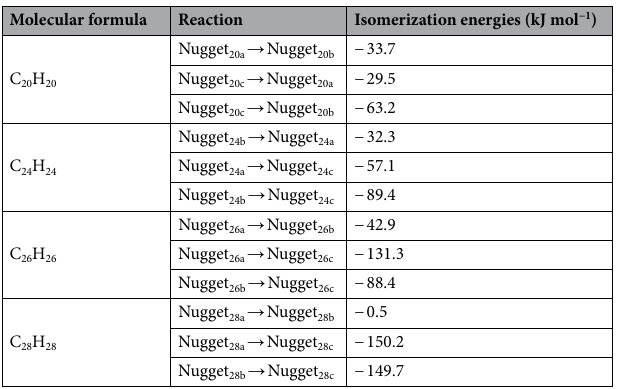
Table 2. Isomerization energies between structural isomers for each of the following molecular formulas: C 20 H 20 , C 24 H 24 , C 26 H 26 , and C 28 H 28 . All values were calculated by the model chemistry ωB97XD/6-31G*. The energy values are given in kJ mol −1 because they refer to chemical reactions involving one mole of reactant only.